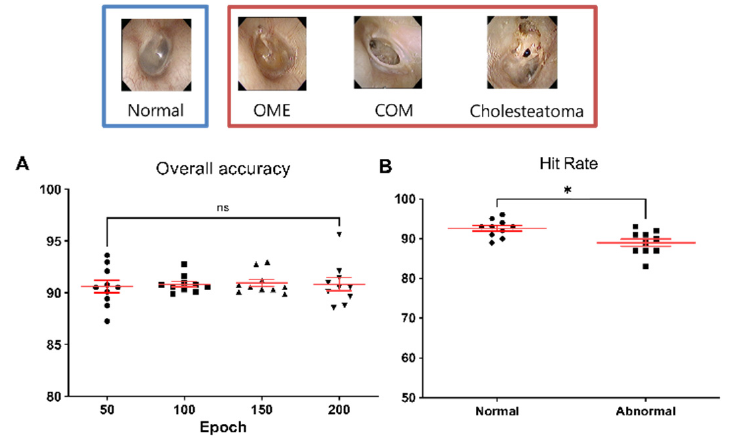
Figure 4. The accuracy and hit rates for differentiating normal versus abnormal tympanic membranes. ( A ) Overall accuracy of the machine learning model, according to epoch. ( B ) Mean hit rates for normal (92.6%) and abnormal (89.0%) tympanic membranes and showed significant difference ( * p < 0.0087). In Level II, the mean accuracy of the network ranged from 86.3% to 89.0%, according to the epoch, and the epoch value of 200 showed the highest performance (Figure 5A).